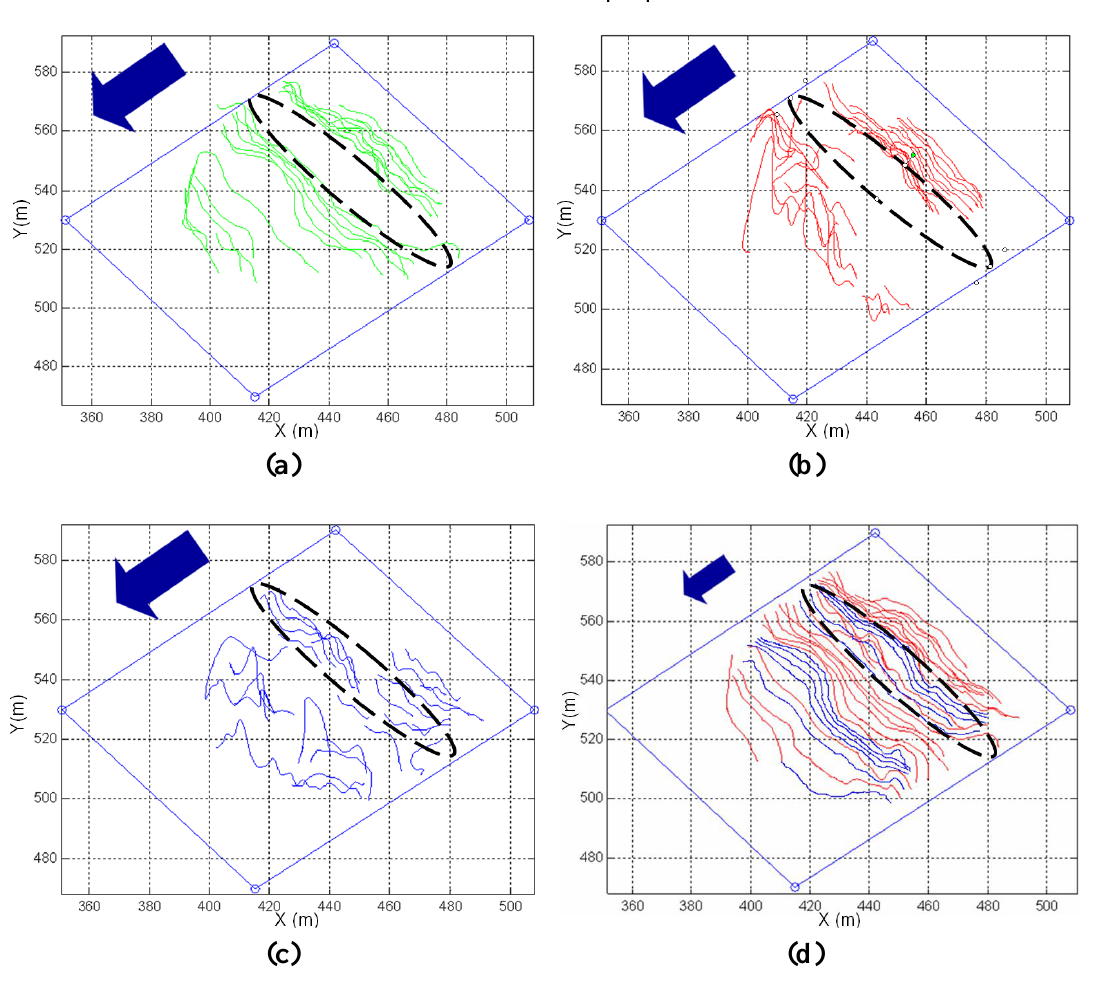
Figure 16. Evolution of the fire-front location in an experiment of a forest fire spreading down-slope, obtained individually from: (a) one visual camera onboard an UAS; (b) one frontal ground visual camera; (c) one ground infrared camera. (d) Fire fronts merged from the measurements from the three cameras with the proposed